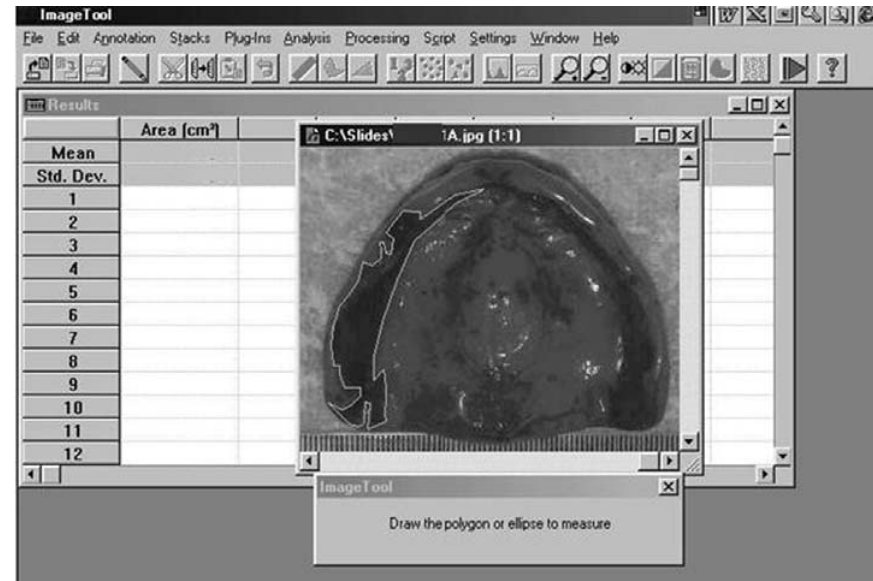
Figure 1- Stained regions were measured using image processing software (Image Tool